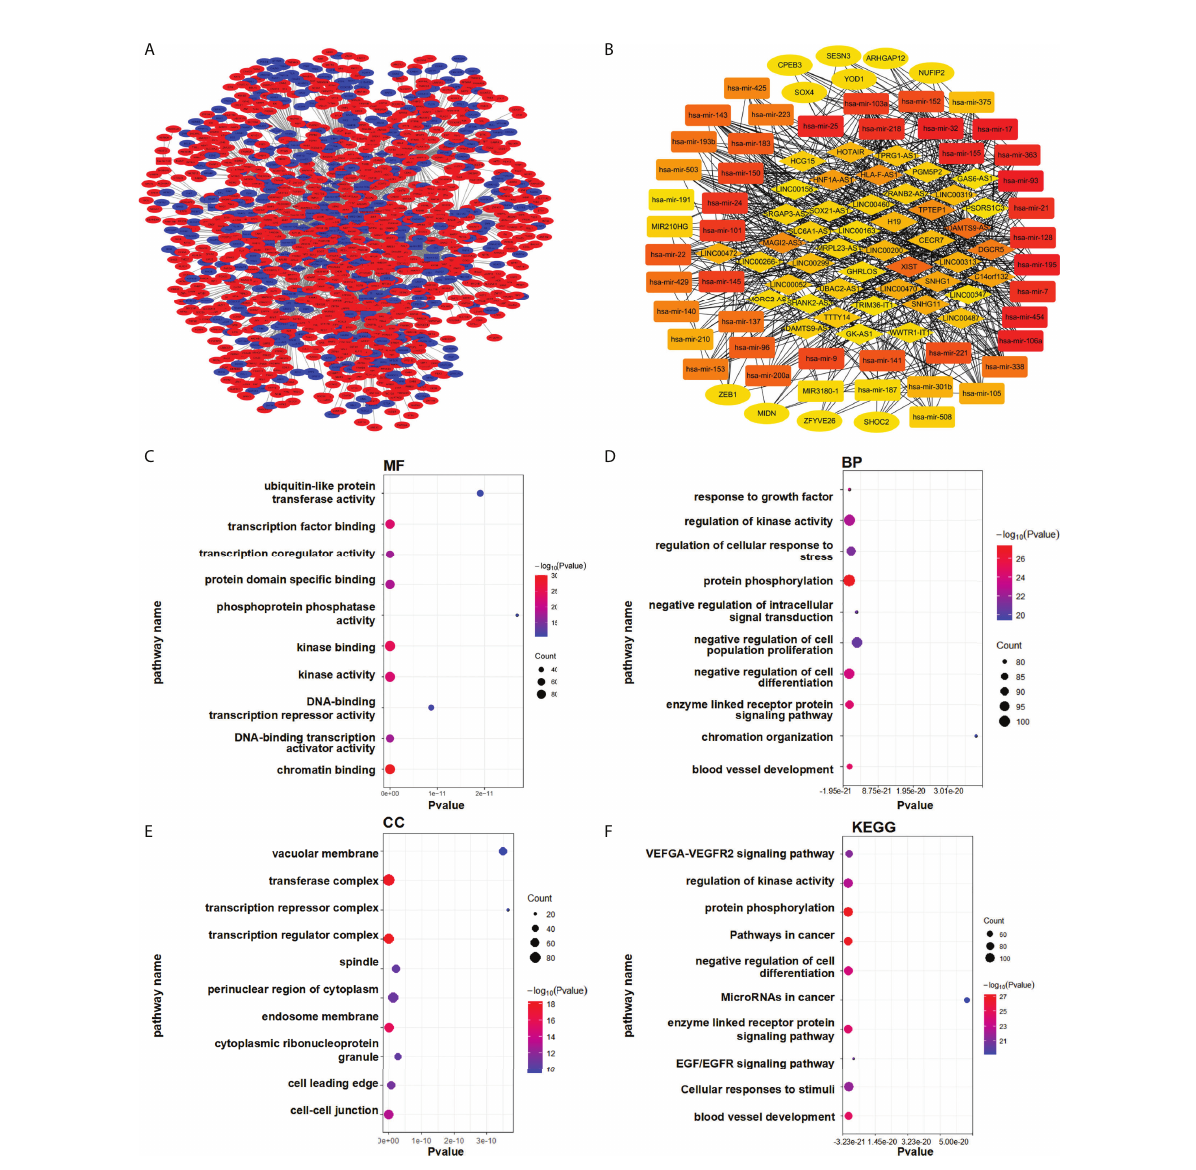
FIGURE 4 Enrichment analysis of the regulatory network. (A) Triple ceRNA network. (B) Top 100 hub ceRNAs in the network. (C – F) Functional enrichment analysis of the DEmRNAs. (C) MF, (D) BP, (E) CC, and (F)